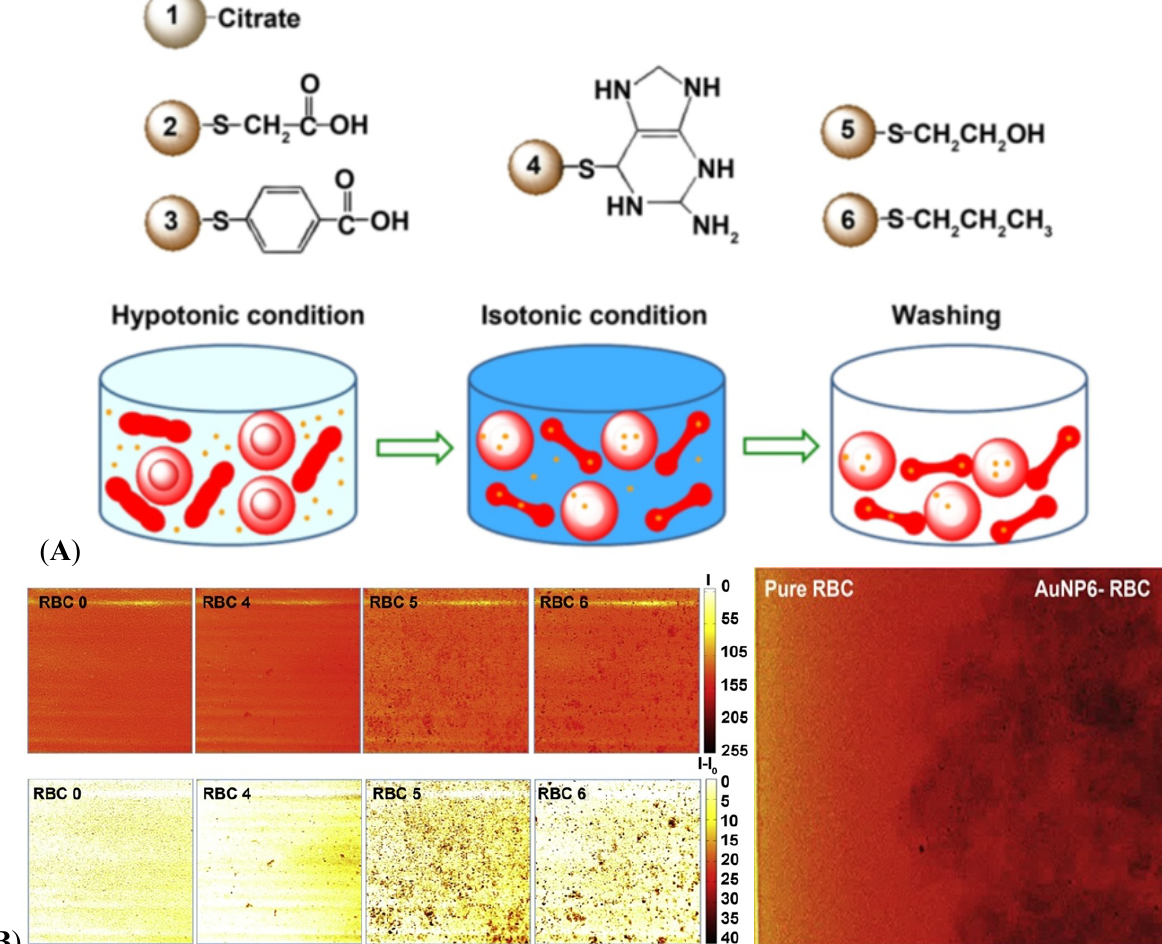
Figure 8. ( A ) Six types of AuNPs of 20 nm diameter are designed for incorporation into RBCs. The AuNPs are reduced by sodium citrate tribasic dihydrate (AuNP 1). For surface-modification, each AuNP are covered with thioglycolic acid (SH-CH COOH) 2 (AuNP 2), 4-mercaptobenzoic acid (SH-Ph-COOH) (AuNP 3), 6-thioguanine (SH-C H N ) 5 4 5 CH OH) (AuNP 5), and 1-propanthiol (AuNP 4), 2-mercaptoethanol (SH-CH 2 2 (SH-CH CH CH ) (AuNP 6) [83]. ( B ) (left) X-ray images of selected RBC 0 (without 2 2 3 AuNP incorporation), RBC 4 (AuNP 4-incorporated RBC), RBC 5 (AuNP 5-incorporated RBC), and RBC 6 (AuNP 6-incorporated RBC) are detected by the enhanced phase contrast together with enhanced absorption contrast. The upper images are flat-field-correction images expressed by the absolute X-ray absorption (I). The lower images show the X-ray ). The scale bars absorption intensities subtracted by the corresponding background (I–I 0 indicate the degree of absorption. The size of the images is 500 mm × 500 mm. A short video of X-ray images capturing the time-dependent flow motion of RBC 6 is available in Ref. [63]. Adapted by permission from